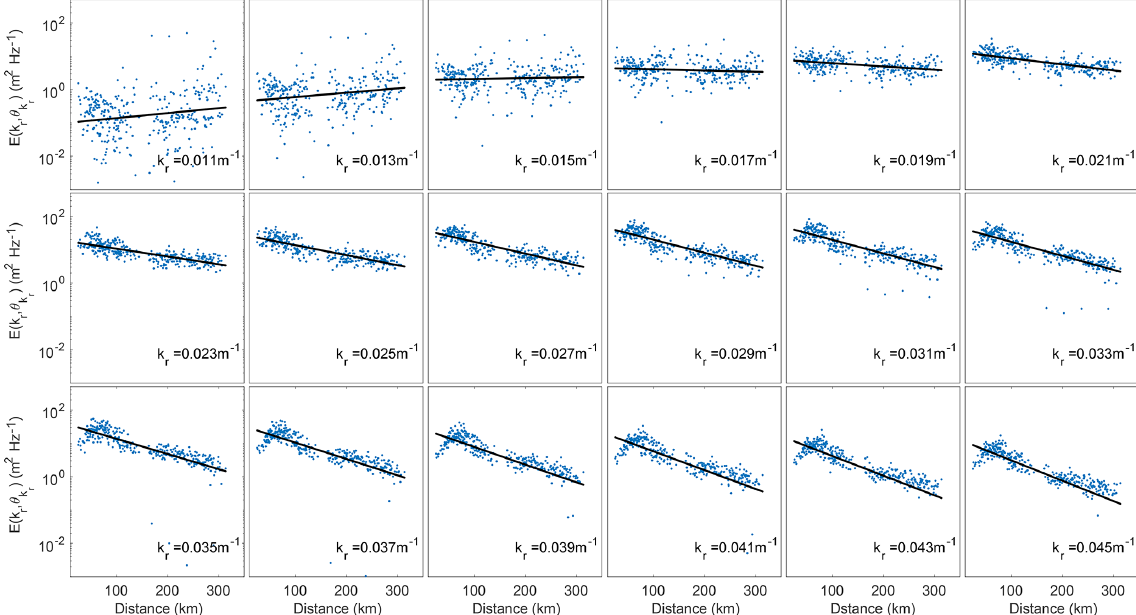
Figure B1. Evolution of dominant wave energy component over long distances within a given longitude interval 150 ± 0 . 1 ◦ W at different wave numbers. The horizontal axis is the distance along a longitude from 74.5 ◦ N towards the north.